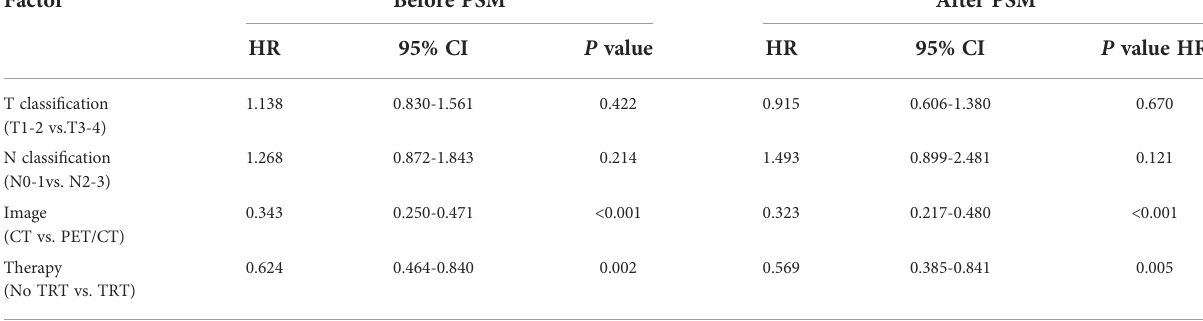
TABLE 4 Multivariate analysis between prognostic factors and overall survival. Factor Before PSM After